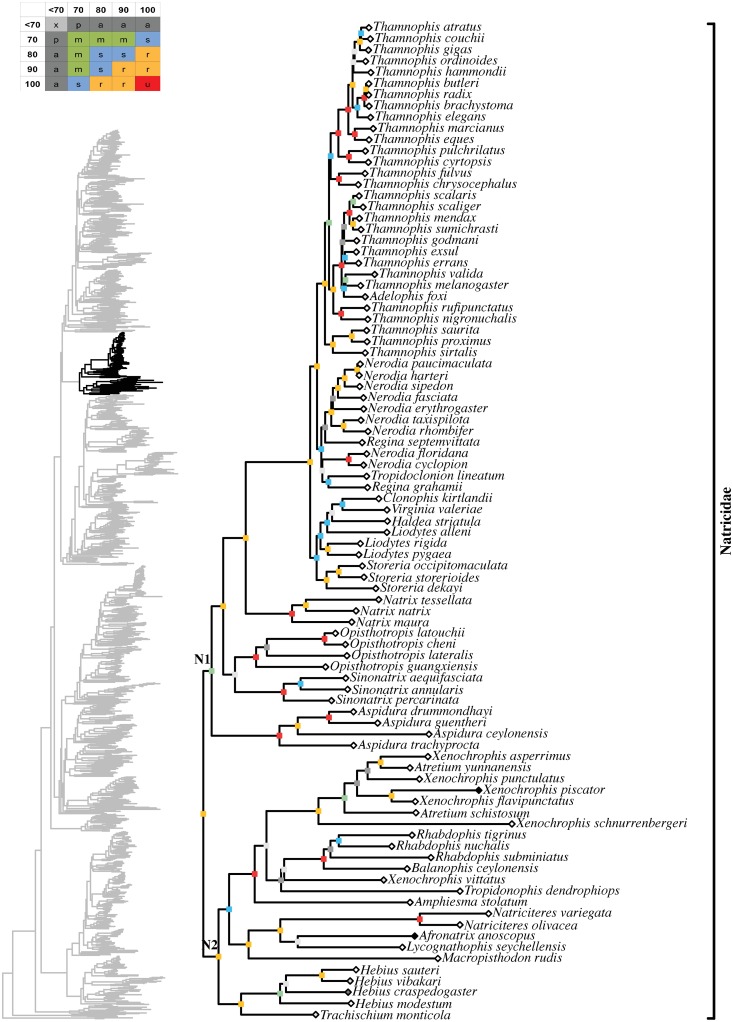
Maximum likelihood species-level phylogeny of Colubroides
(continued).Family Natricidae.